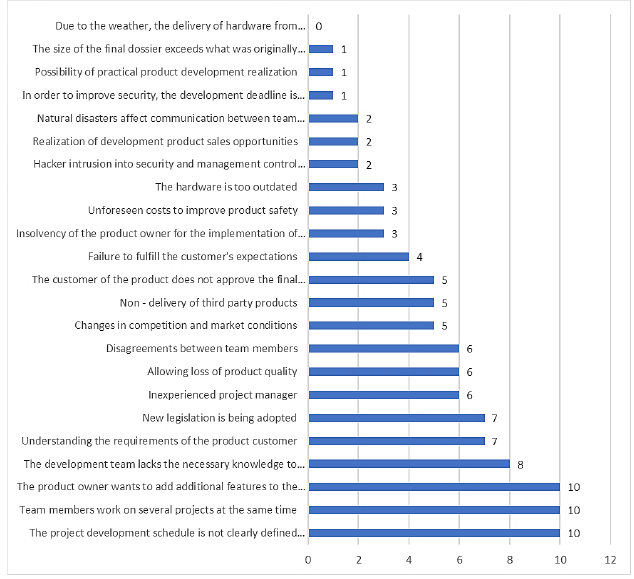
Fig. 8. Frequency of risk examples in the surveyed companies .